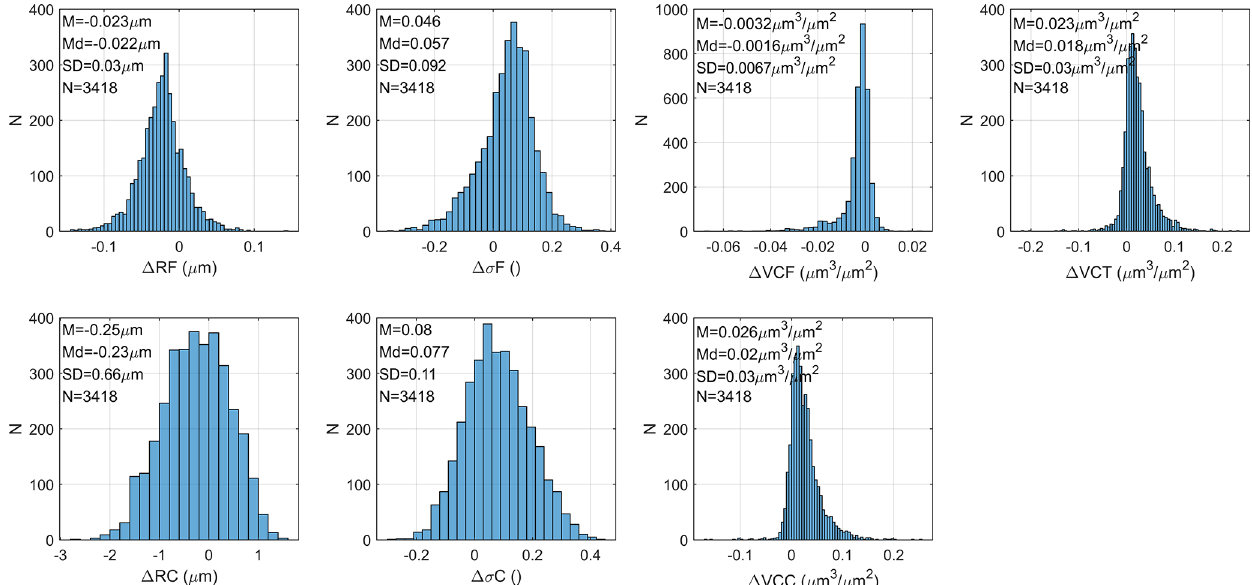
Figure 21. Frequency histograms of the (cid:49) differences in the aerosol size distribution properties retrieved by GRASP with the multi-pixel approach (GRASPmp-CAM) and the ones retrieved by AERONET. The mean (M), median (Md) and standard deviation (SD) of the differ- ences are also shown. The size distribution properties are volume median radius of fine (RF) and coarse (RC) modes, standard deviation of log-normal distribution for fine ( σ F) and coarse ( σ C) modes, and aerosol volume concentration for fine (VCF) and coarse (VCC) modes and the total value